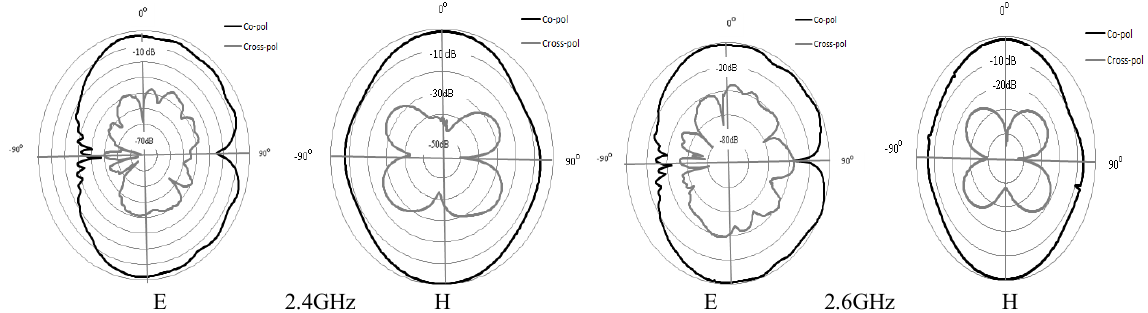
Figure 5. Measured E-Plane and H-Plane Co-polarization and Cross-polarization patterns of Antenna 3 at different frequencies